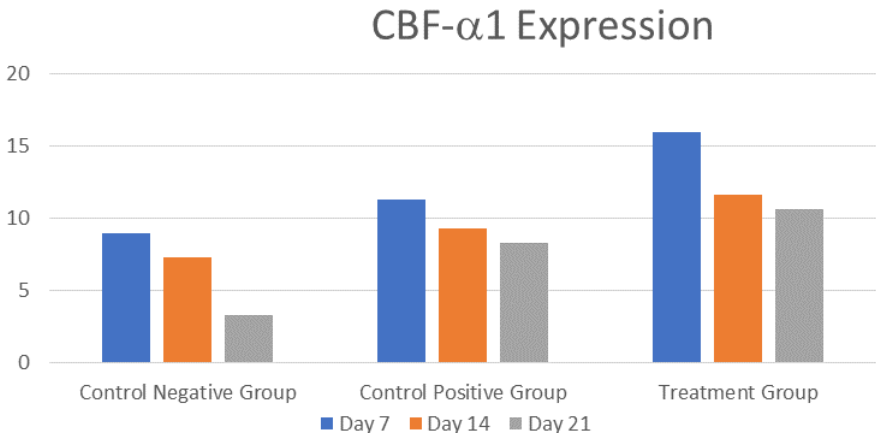
Figure 2. Mean core-binding factor subunit- α1 (CBF- α 1) expression on Days 7, 14, 21 in each treatment group